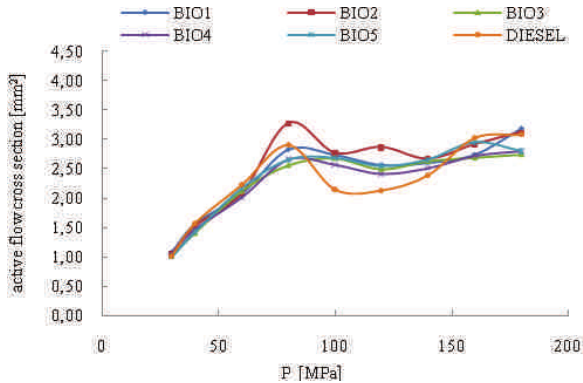
Fig. 3. Comparison of the active flow cross sections of tested fuels at 40°C